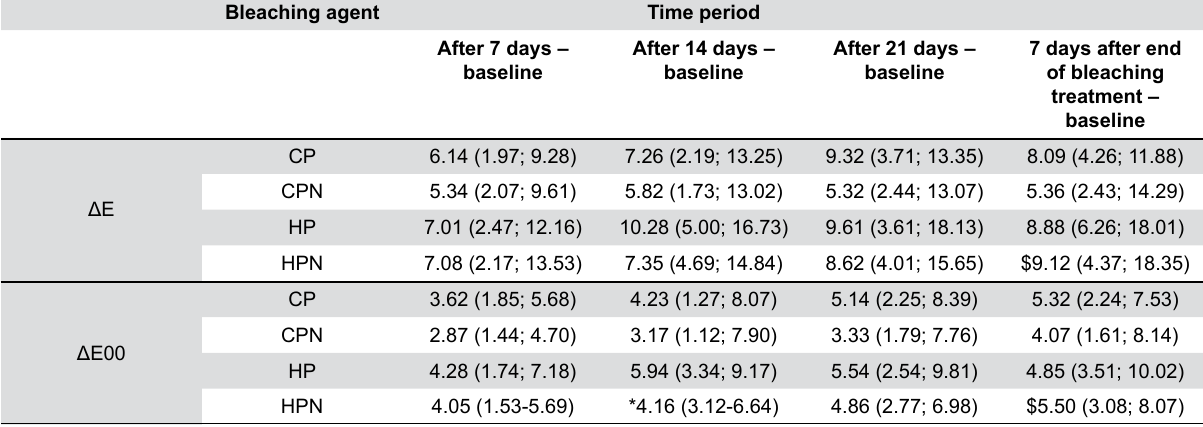
Table 4- Median (minimum value; maximum value) color variation (CIEL*a*b* system and CIEDE2000) as a function of group and time